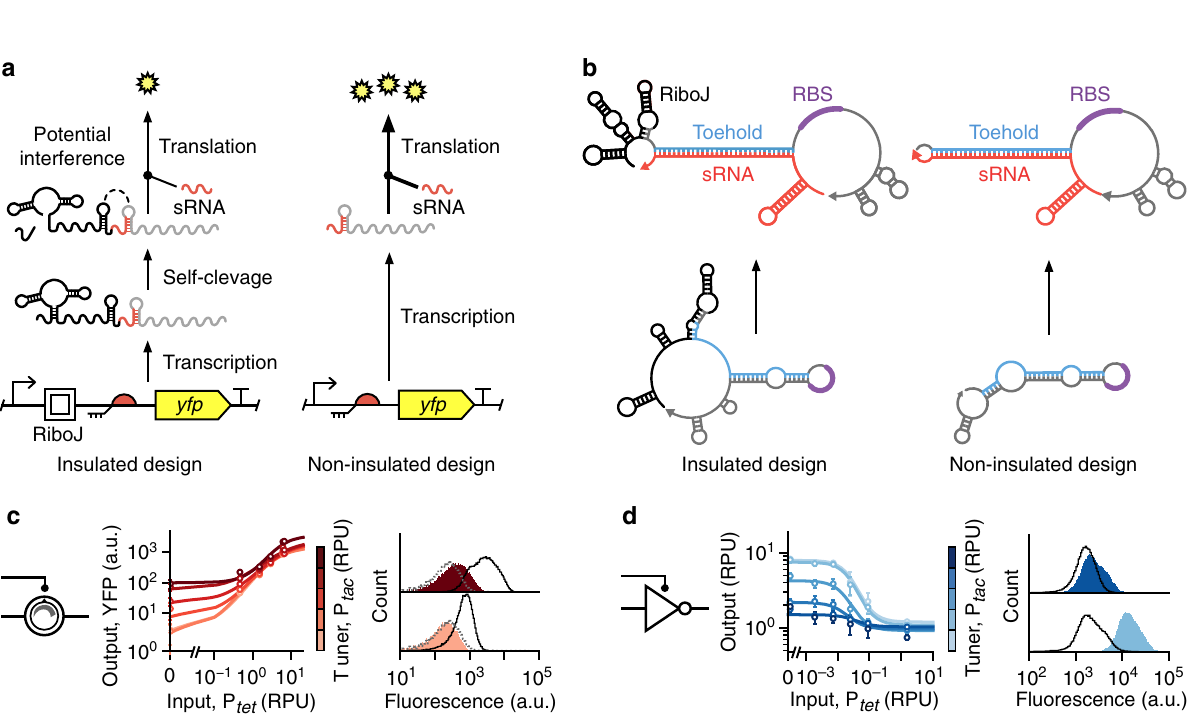
Fig. 4 Self-cleaving ribozyme insulators affect tunable device performance. a Original designs of both the TES and tunable NOT gate include a RiboJ insulating element, which can potentially interfere with binding of the tuner sRNA to the THS. b RNA secondary structure predictions for THS mRNA alone and with a complimentary tuner sRNA bound. Separate structures shown when the RiboJ insulating element is present (left) and absent (right). c Experimentally measured response functions (left) and fl ow cytometry distributions of the output YFP fl uorescence (right) for the TES with the RiboJ insulator removed. d Experimentally measured response functions (left) and fl ow cytometry distributions of the YFP fl uorescence output (right) for the tunable NOT gate with the RiboJ insulator removed. Points in all response functions denote the average of three biological replicates and error bars show ±1 standard deviation. Each line shows a fi tted Hill function for a fi xed tuner input (color scale light – dark: 0.002, 0.03, 0.15, 0.43, 0.9, 2.6 RPU). All fl ow cytometry distributions are shown for low (bottom; 0.002 RPU) and high (top; 2.6 RPU) tuner promoter activity. Black outlined distributions correspond to a high input promoter activity (6.6 RPU for the TES and 1.5 RPU for the NOT gate) and fi lled red/blue distributions to a low input promoter activity (0.002 RPU). Cell auto fl uorescence is shown by the dashed gray line. Source data are available in the Source Data fi